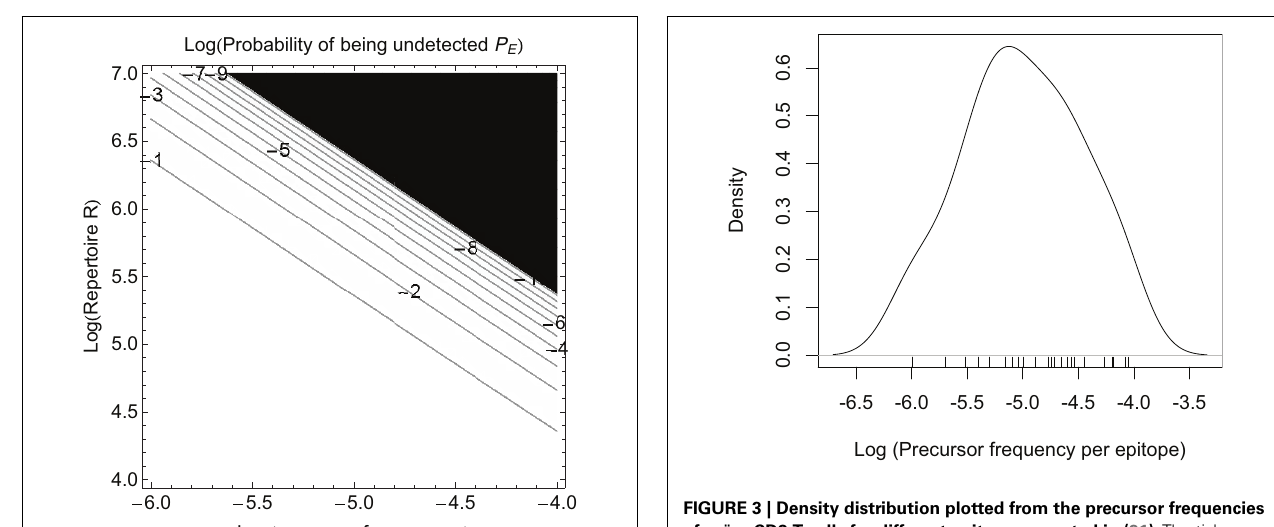
FIGURE 3 | Density distribution plotted from the precursor frequencies of naïve CD8 T cells for different epitopes reported in (31) .The tick marks on the top of the x-axis indicate individual epitopes. Note the log scale on the x-axis. with previous in vivo estimates of precursor frequencies.